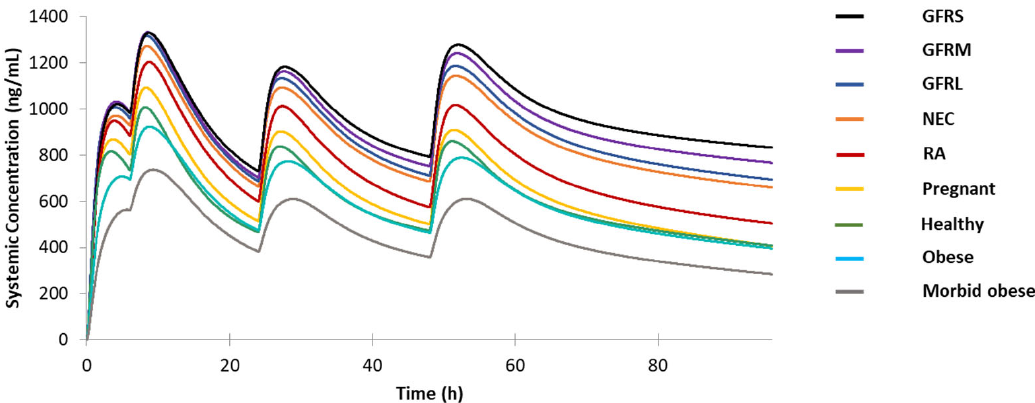
Figure 3. Predicted drug plasma concentration for healthy volunteers under the FDA-guided dosing regimen of 620 mg base followed by 310 mg base at 6 h, 24 h, and 48 h.